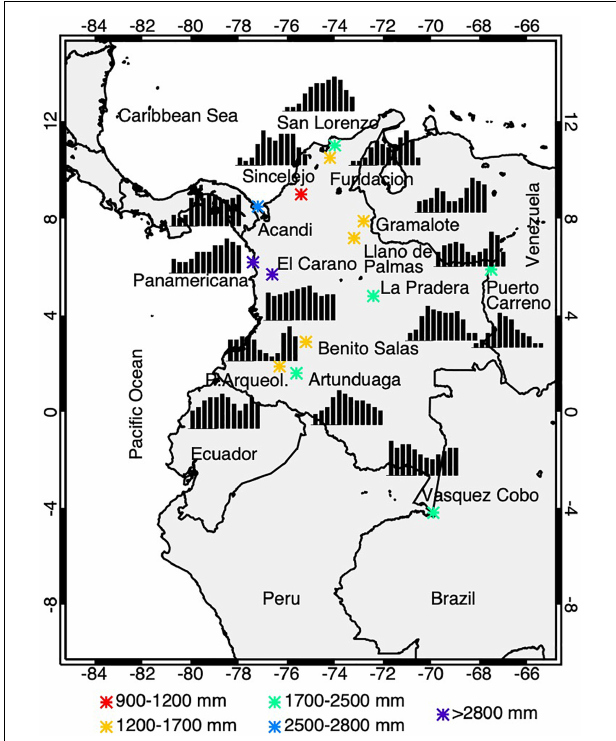
FIGURE 10 | Mean annual cycle of precipitation in different rain gauges over the north tropical Andes of Colombia (north of 8 ◦ S). Adapted from Ricaurte et al.